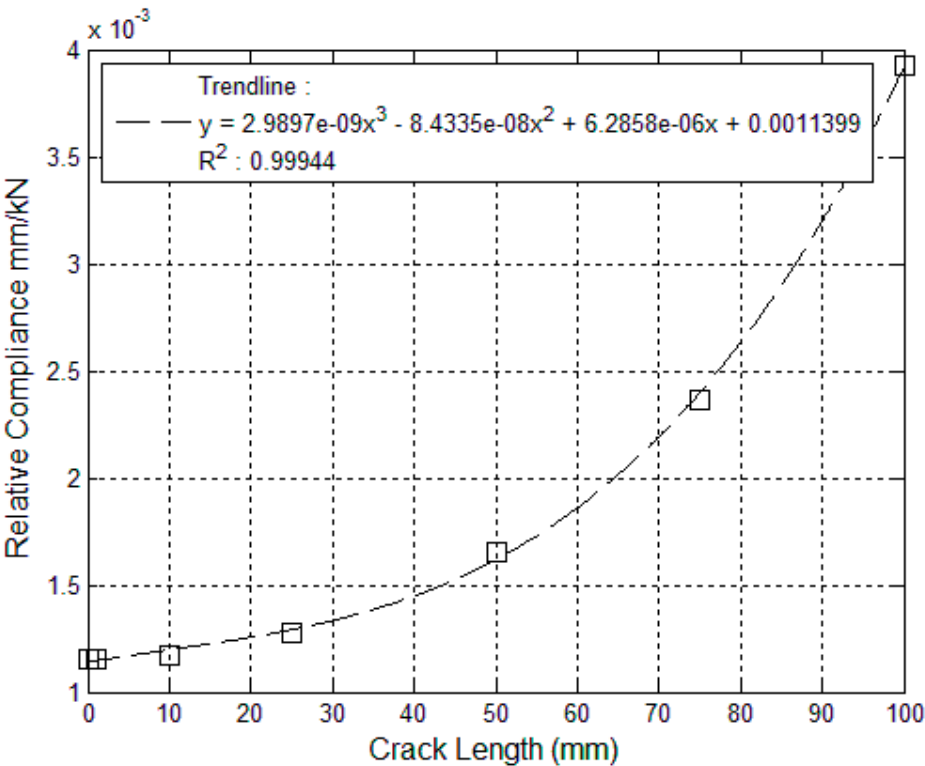
Figure 4. Beam compliance versus crack length theoretical curve.